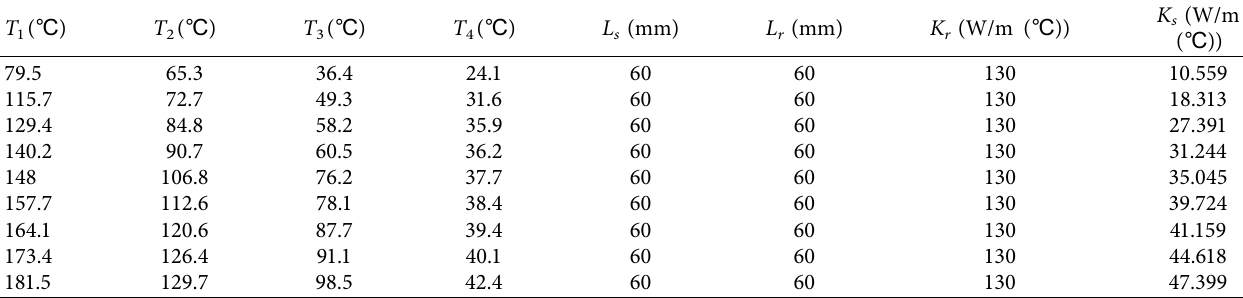
Table 5: Thermal conductivity (W/m ( ℃ ) ) of Ni-Cu alloy+3% TiO